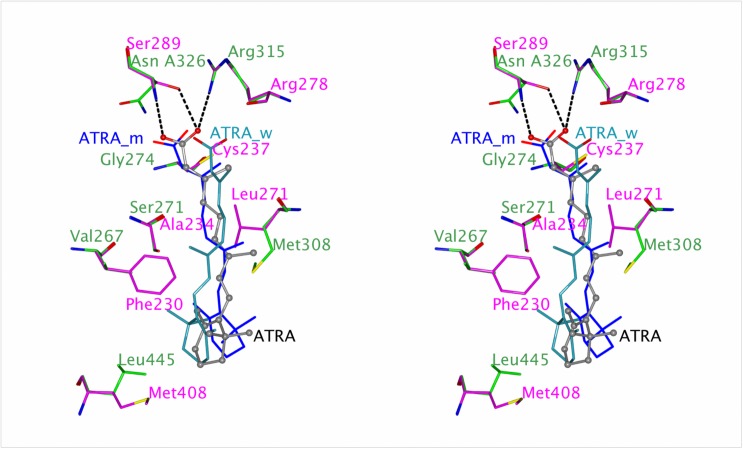
Stereo view of ATRA bound to the ligand binding pocket of a CgRAR model.Superimposition of model CgRAR (purple) on the crystal structure of HsRARγ LBD (green) bound to human RAR agonist ATRA. Original ATRA (grey) bound to HsRARγ LBD template (pdb ID: 2LBD); ATRA (light blue) to CgRAR wildtype, ATRA (dark blue) bound to mutated CgRAR. Divergent residues as well as arginines binding to the COOH group of ATRA including hydrogen bonds are indicated.